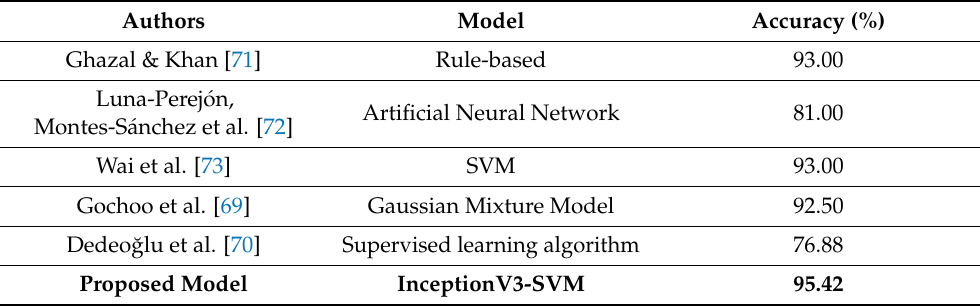
Table 9. Evaluation of the test